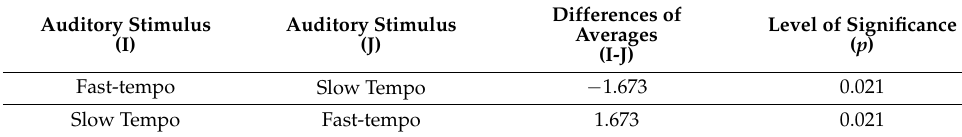
Table 4. Comparison according to the types of auditory